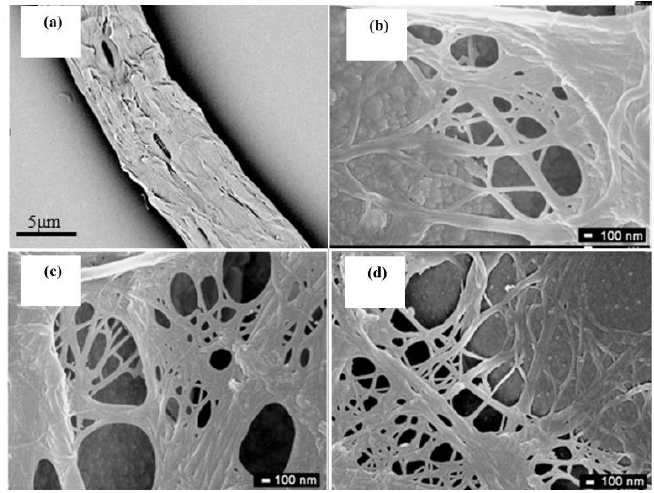
Figure 4. SEM images of original cellulose ( a ) and nanocellulose carbamates fibers (CCNF) from CC with DS = 0.123 ground at pH = 7 ( b ), pH = 3 ( c ), pH = 1 ( d ).